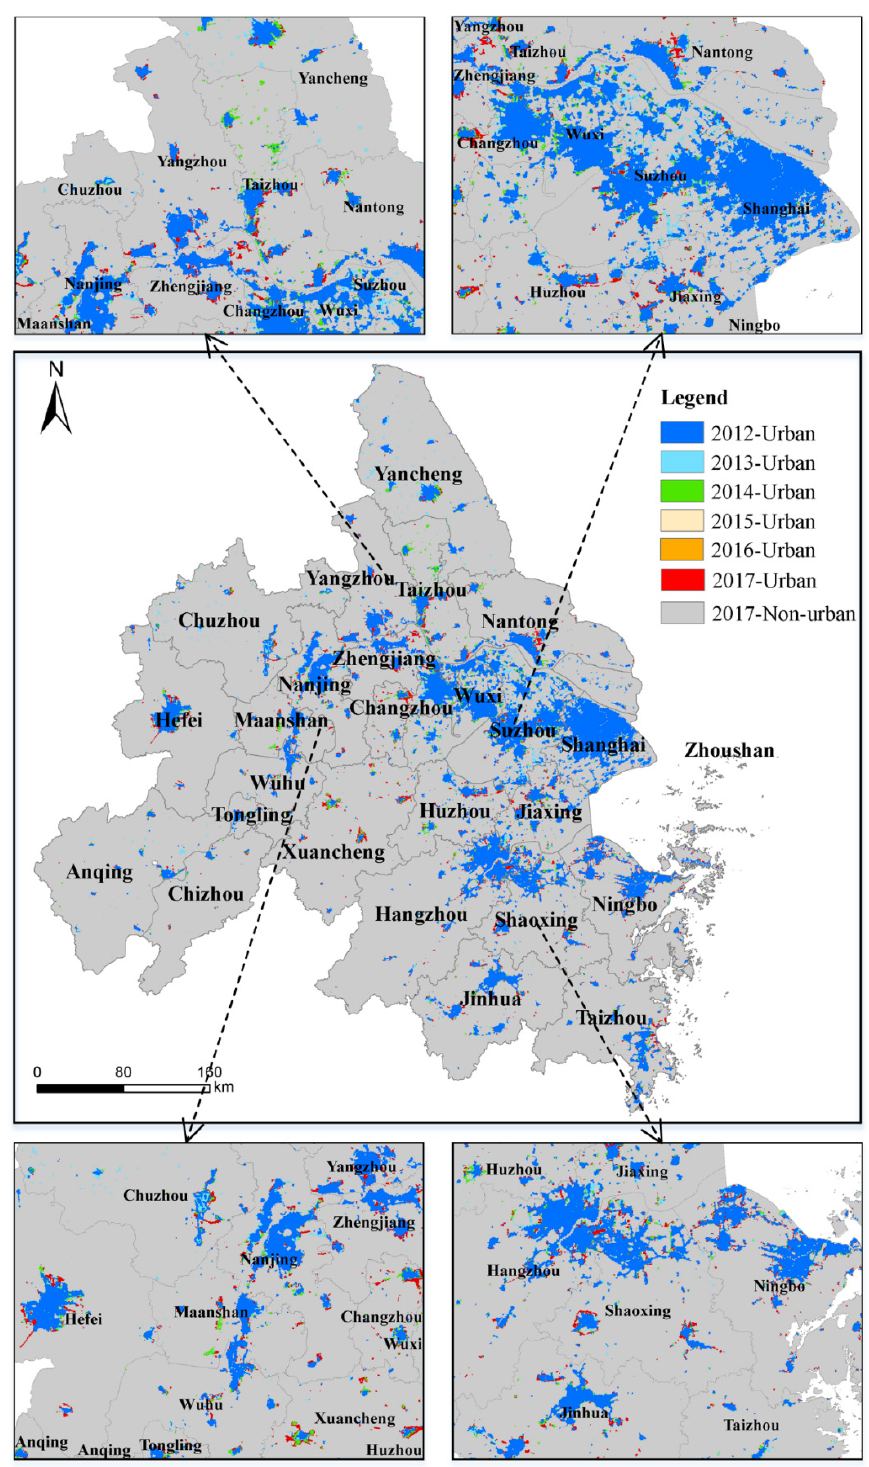
Figure 4. Urban expansion of the study area from 2012 to 2017.